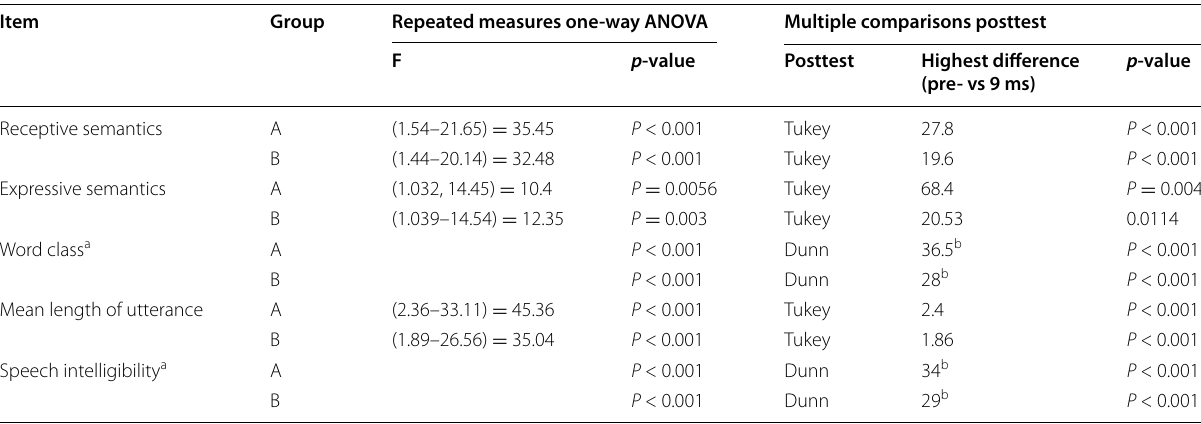
Table 4 Comparison of language parameters among different time‑points within groups